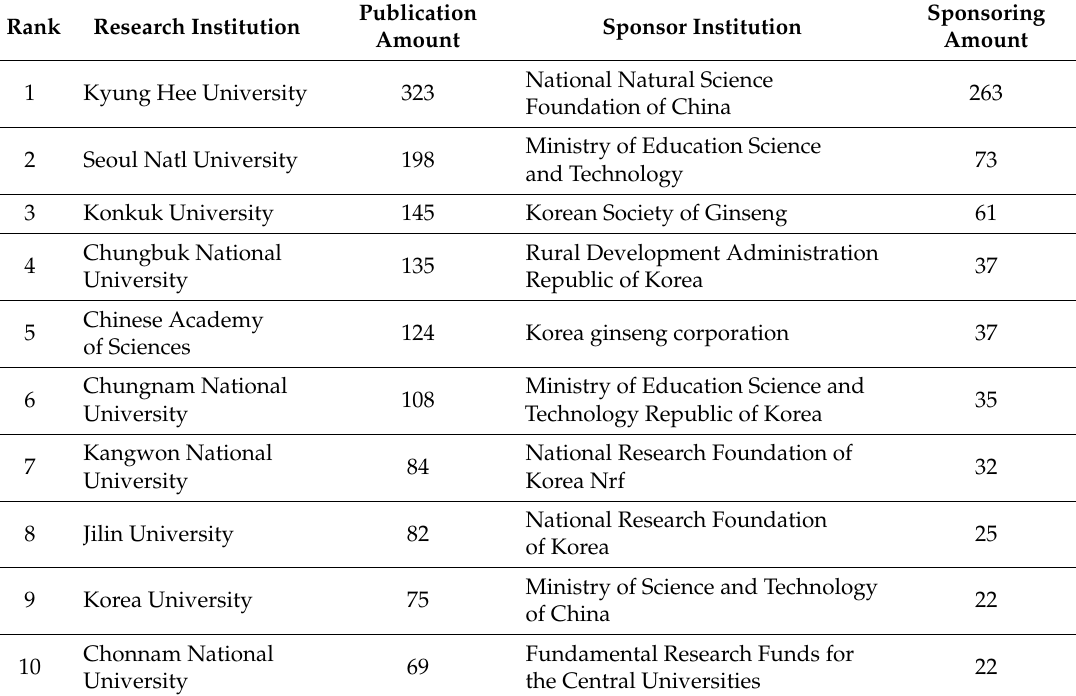
Table 1. Top 10 highest publishing and sponsoring institutions in P. ginseng